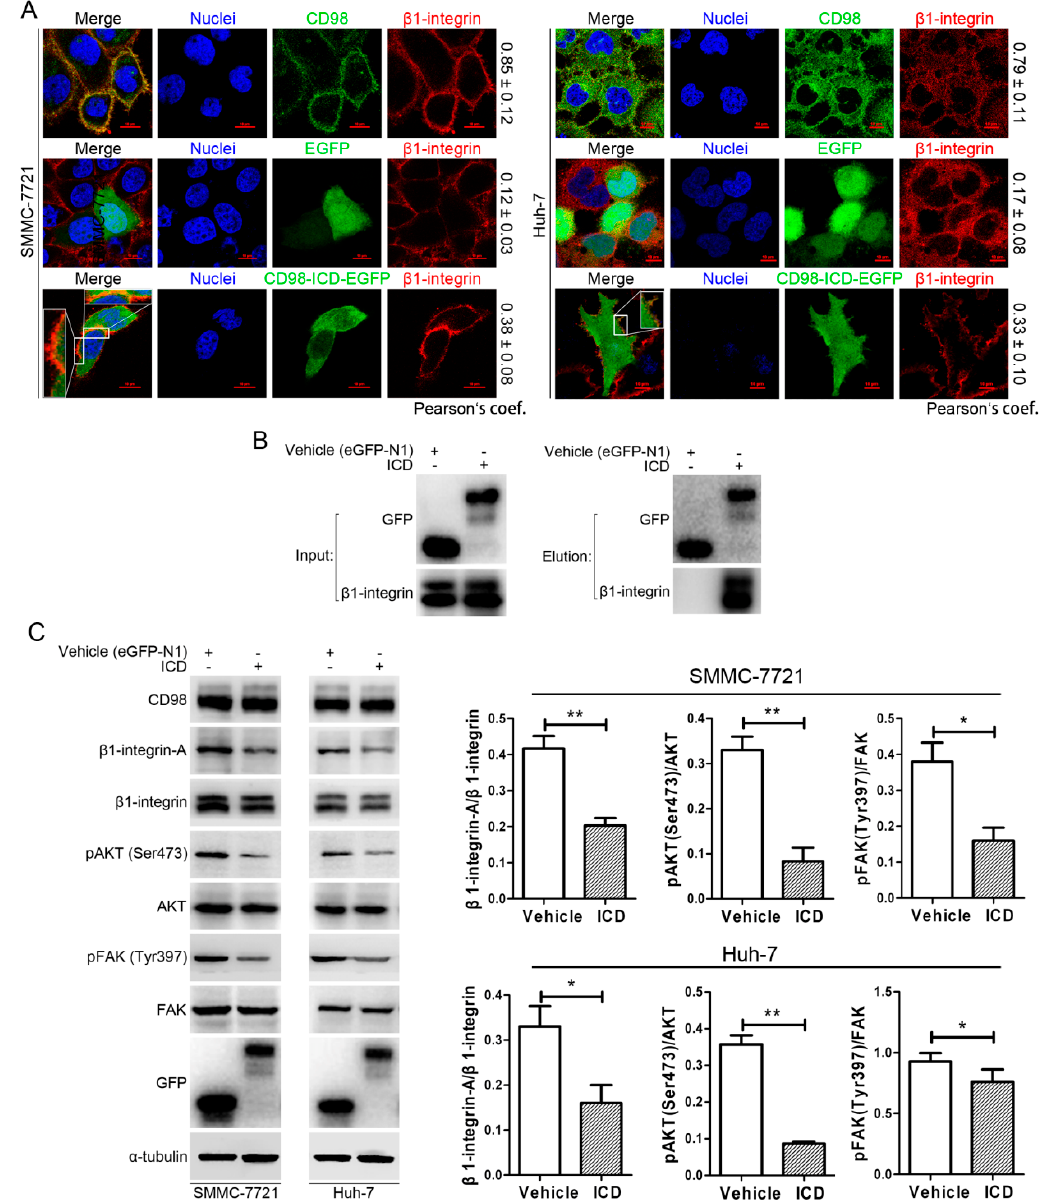
Figure 4. CD98-ICD inhibits β 1-integrin signaling. ( A ) Co-localization of β 1-integrin and CD98-ICD in SMMC-7721 and Huh-7 cells. The co-localization of β 1-integrin (red) and CD98 (green) was first analyzed as a positive control ( upper panel). Then, after cells were transfected with eGFP-N1 ( middle panel) or CD98-ICD-EGFP ( lower panel) for 36 h, β 1-integrin was visualized to analyze co-localization with CD98-ICD. (Pearson’s coefficient is indicated as numerical data on the right of each panel, n > 3). Nuclei: blue. Bar, 10 µ m; ( B ) Co-IP analyses of β 1-integrin and CD98-ICD interaction in SMMC-7721 cells; ( C ) changes in the molecular expression patterns were detected in SMMC-7721 and Huh-7 cells transfected with EGFP-N1 or CD98-ICD-EGFP. Western blot scanning densitometry for three independent experiments is shown on the right. Blots were probed for β 1-integrin, AKT, or FAK independently to ensure equal protein loading. * p < 0.05, ** p < 0.01.